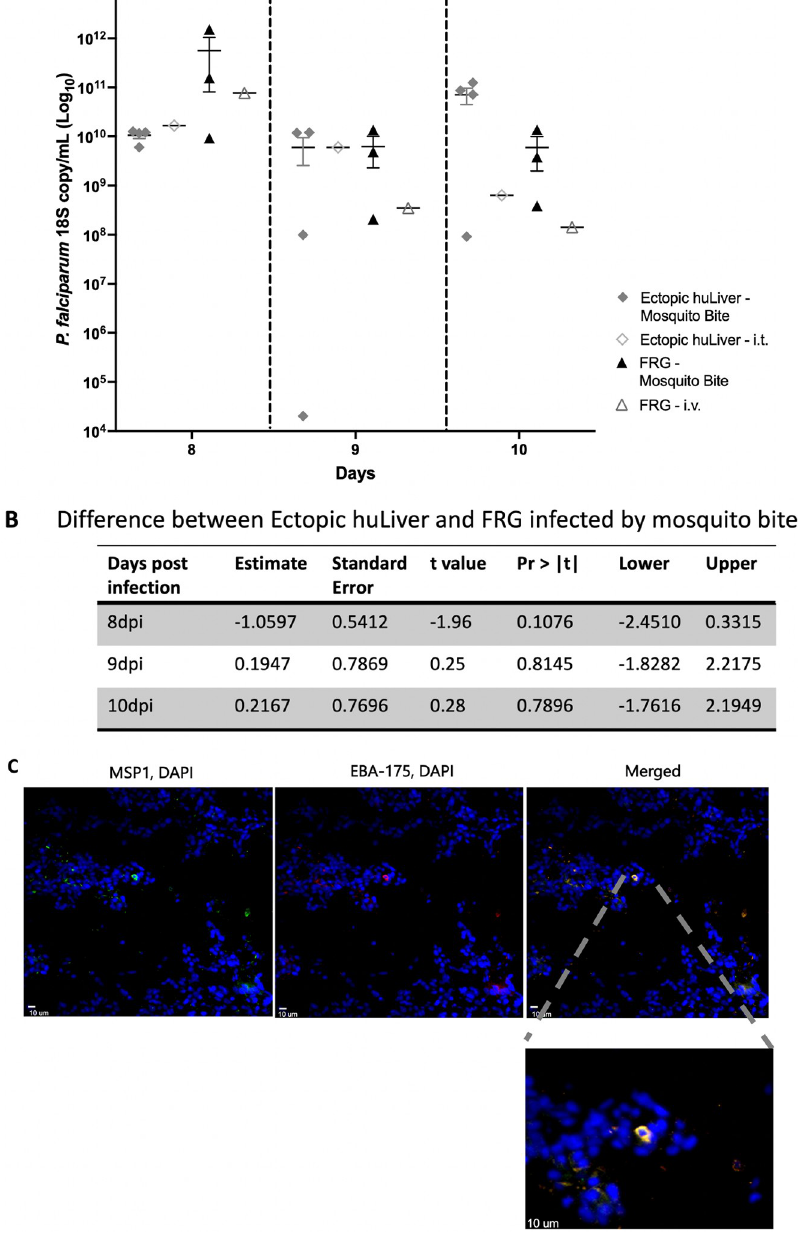
Fig 2. Route of infection comparison in NSG engrafted ectopic huLiver and FRG-huHep mice with the P . falciparum strain NF54HT-GFP-luc. Ectopic huLiver engrafted NSG, and FRG-huHep mice were infected with the P . falciparum strain NF54HT-GFP-luc. Routes of infection were compared between the ectopic huLiver and FRG-huHep mice. For comparison ectopic huLiver mice (n = 4) and FRG-huHep mice (n = 3) were infected via mosquito bite challenge and compared to infection from sporozoites (100,000 NF54HT-GFP-luc) administered via i.t (ectopic huLiver n = 1) or i.v. (FRG-huHep n = 1). IHC and qRT-PCR analysis were performed to validate and characterize the infection. (A) Blood-stage infection was quantified using qRT-PCR to detect P . falciparum 18S rRNA transcripts in blood samples collected at 8, 9, and 10 dpi in both ectopic huLiver engrafted NSG and FRG-huHep mice. (B) Statistical analysis to demonstrate differences in infection levels between FRG-huHep and ectopic huLiver mice infected by mosquito bite at 8, 9, and 10. (C) Immunohistochemistry analysis using anti-MSP1 and anti-EBA-175 as markers for maturing merozoites, DAPI was used to stain cell DNA at 7